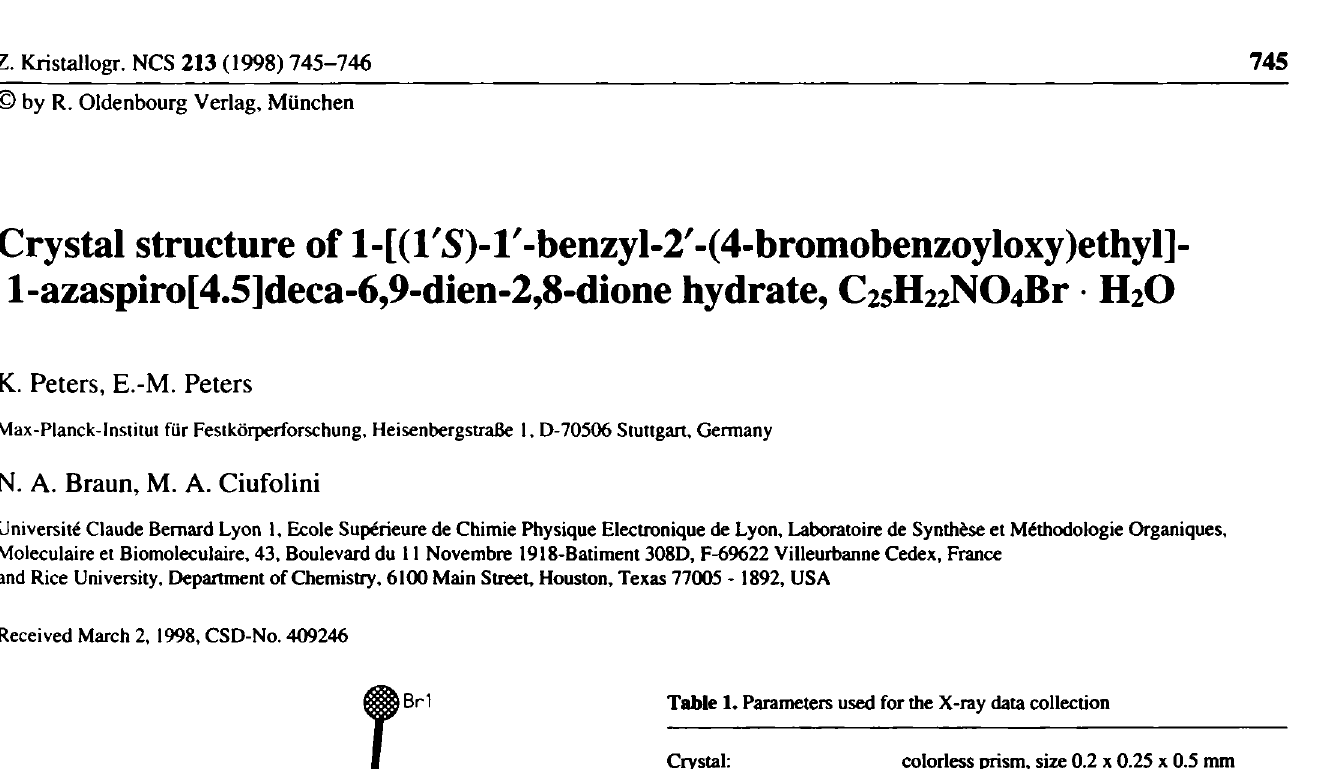
Table 2. Final atomic coordinates and displacement parameters (in